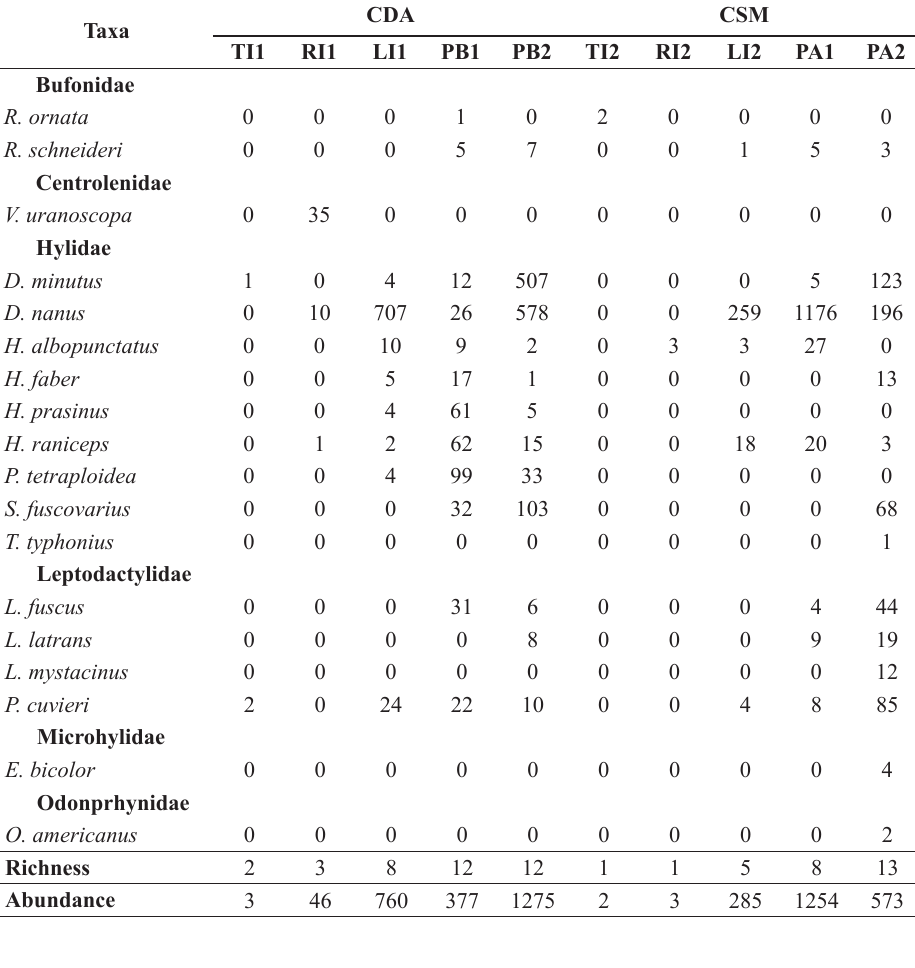
List and maximum abundance of anuran species recorded in all 10 water bodies sampled in the areas CDa and CsM, located in the mid northern region of the state of Paraná, between september 2011 and March 2012. the description of the acronyms and the habitat are listed